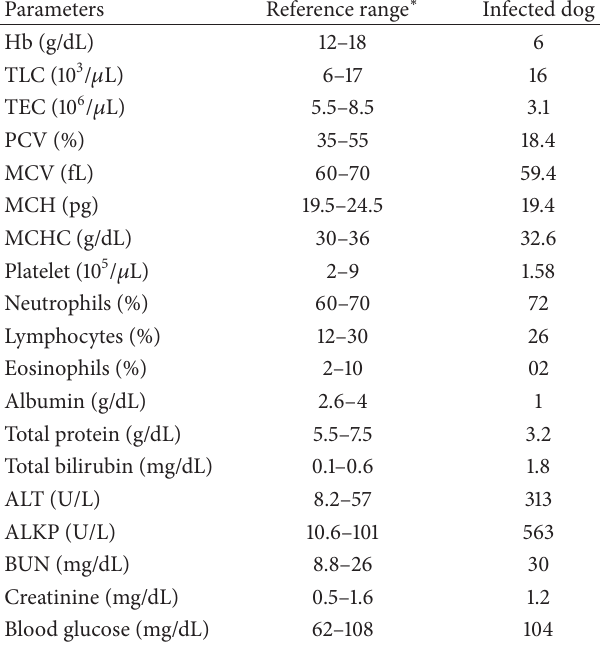
Table 1: Haematobiochemical parameters in the dog infected with Babesia gibsoni .